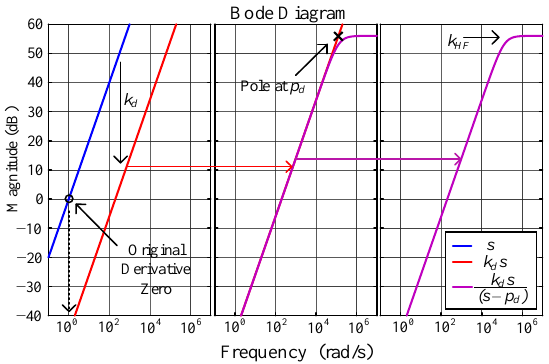
Figure 6. Steps to build the DB transfer function (DBTF) from a pure derivative function (blue—no gains | red—with gains | pink—with gains and added/displaced poles).